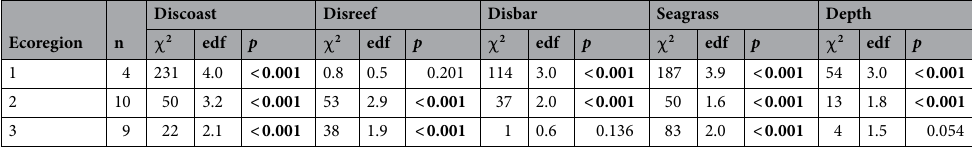
Table 3. Summary of the GAM habitat model selected to describe dugong intensity of use as a function of five environmental predictors per ecoregion. Significant relationships ( p value p < 0.05*) are shown in bold. The number of individual dugongs contributing to the ecoregional models is reported by ecoregion (n). Edf = estimated degrees of freedom. DISCOAST = distance to the coast, DISTREEF = distance to intermediate reef patches, DISBAR = distance to the barrier reef, SEAGRASS = shallow seagrass (< 5 m) density, DEPTH = depth.